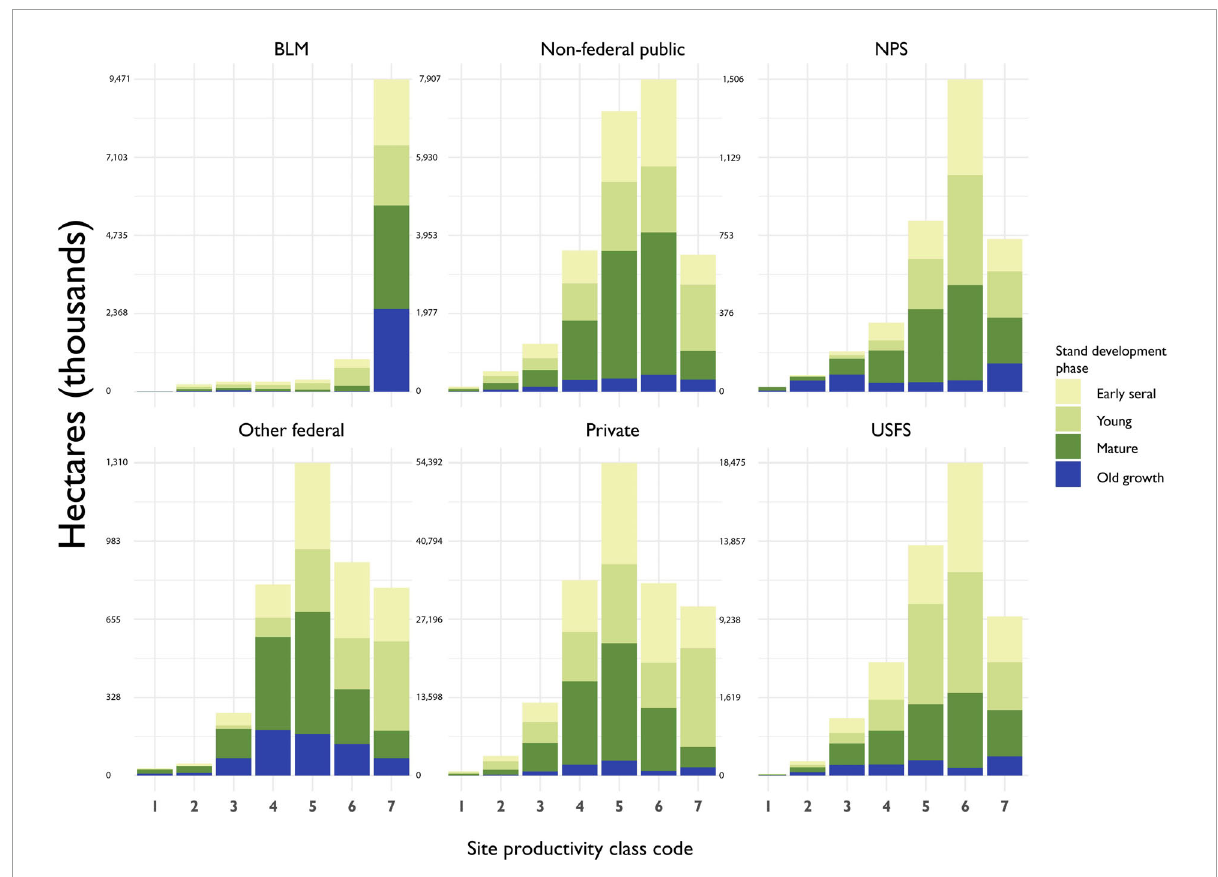
FIGURE7 Estimates of forested area by ownership groups, site productivity class and stand development phase. “NPS”, National Park Service; “Other federal”, Fish and Wildlife Service, Department of Defense, Department of Energy, and other federal agencies; “BLM”, Bureau of Land Management; “Non-federal public”, state/local governments or other non-federal public institutions; “USFS”, United States Forest Service; “Private”, undifferentiated private and Native American